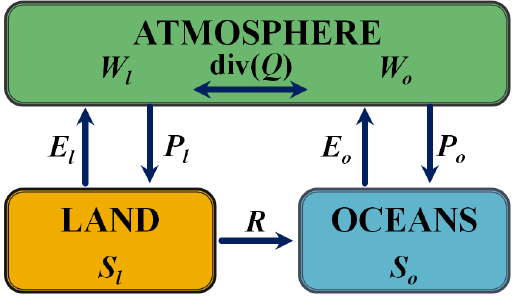
Figure 1: Stocks and fluxes in the global water cycle. Refer to the text for a detailed description of the variables. S l represents the terrestrial water storage, S o the ocean mass, R the global runoff, P the precipitation, E the evapo(transpi)ration, W the total column water vapor and div(Q) the divergence of the vertically integrated water vapor flux. Subscripts l and o designate the spatial average over land and ocean, respectively.